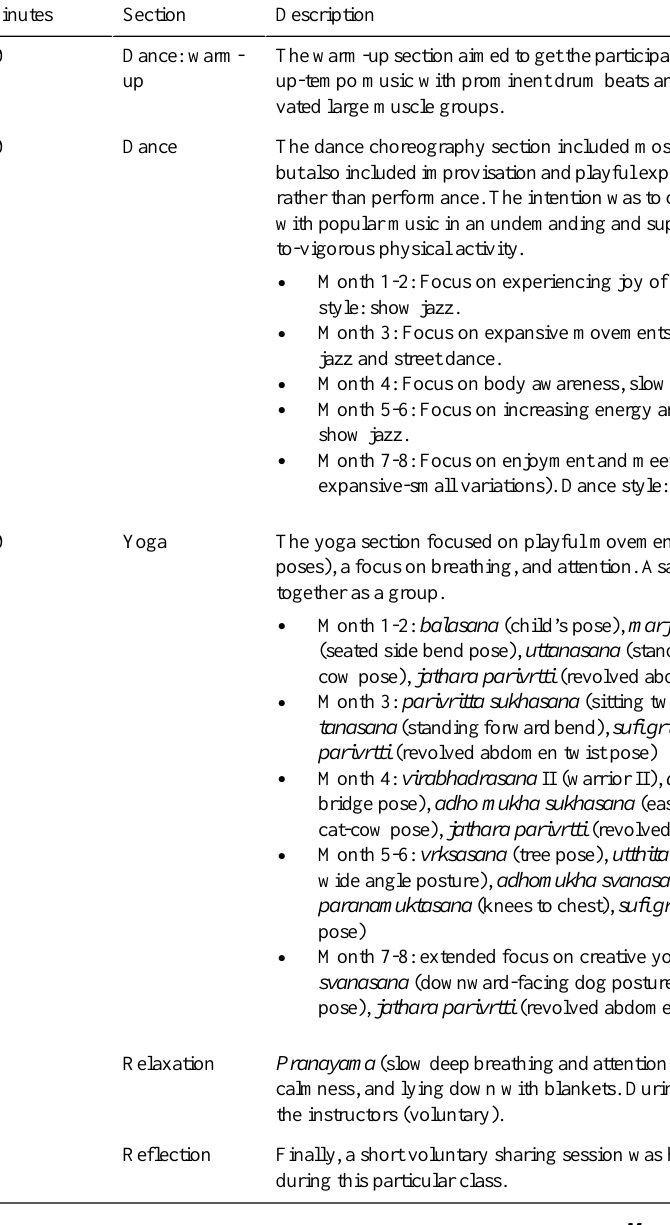
Table 1. The 60-minute Just in TIME dance and yoga